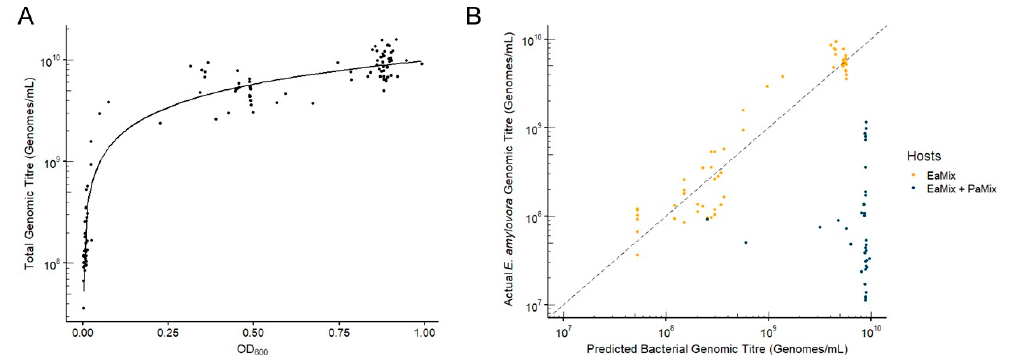
Figure 7. Correlation between OD 600 and qPCR for quantification of E. amylovora in liquid culture. ( A ) A regression of total bacterial genomes ( E. amylovora + P. agglomerans ) in solution compared to OD 600 was used to show the correlation and accuracy of qPCR ( R 2 = 0.93). ( B ) The regression was used to calculate the predicted titer of bacterial genomes on the basis of the OD 600 of the solution, and this was compared to the actual qPCR-determined titer of E. amylovora genomes when E. amylovora was the only bacterium in solution ( ● ) and when P. agglomerans was also present ( ● ). The dotted line represents a 1:1 correlation between the predicted bacterial genomic titer calculated from the OD 600 and the qPCR titer of E. amylovora .